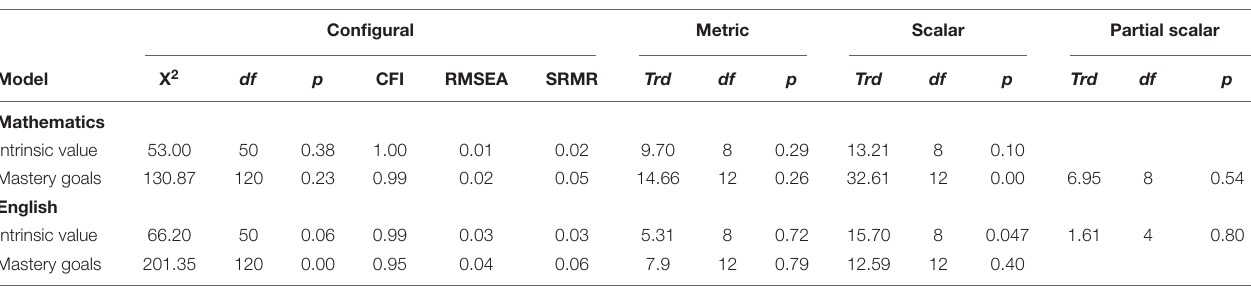
TABLE 3 | Invariance results. Configural Metric Scalar Partial